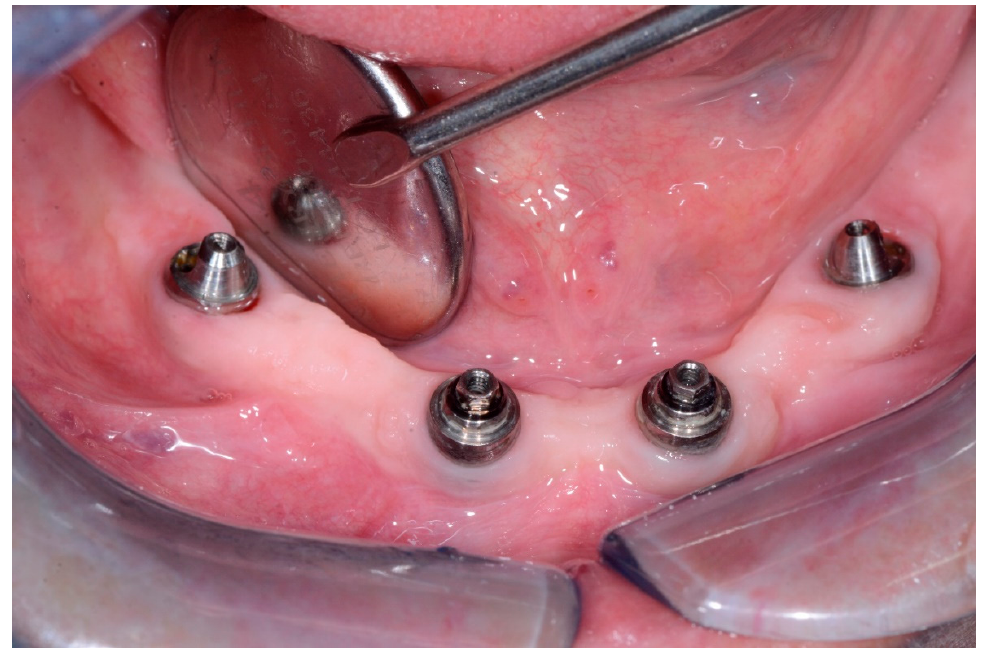
Figure 12. Condition of peri-implant tissues in patient in 6 months after treatment.